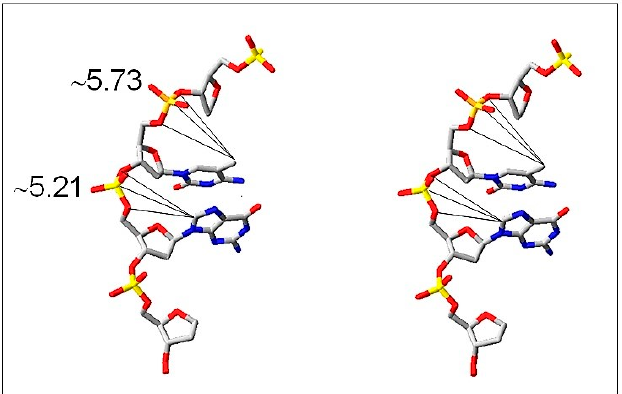
Figure 7. Stereo view of the major groove of DNA where m 5 C and guanosine (C-8) are located and